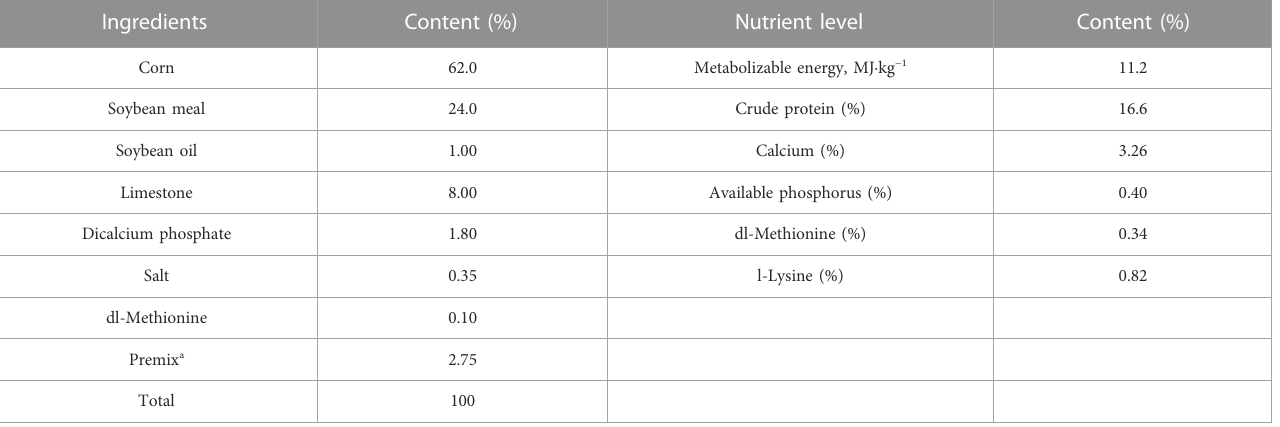
TABLE 2 The composition and nutritional level of the basic diet (air-dried basis).